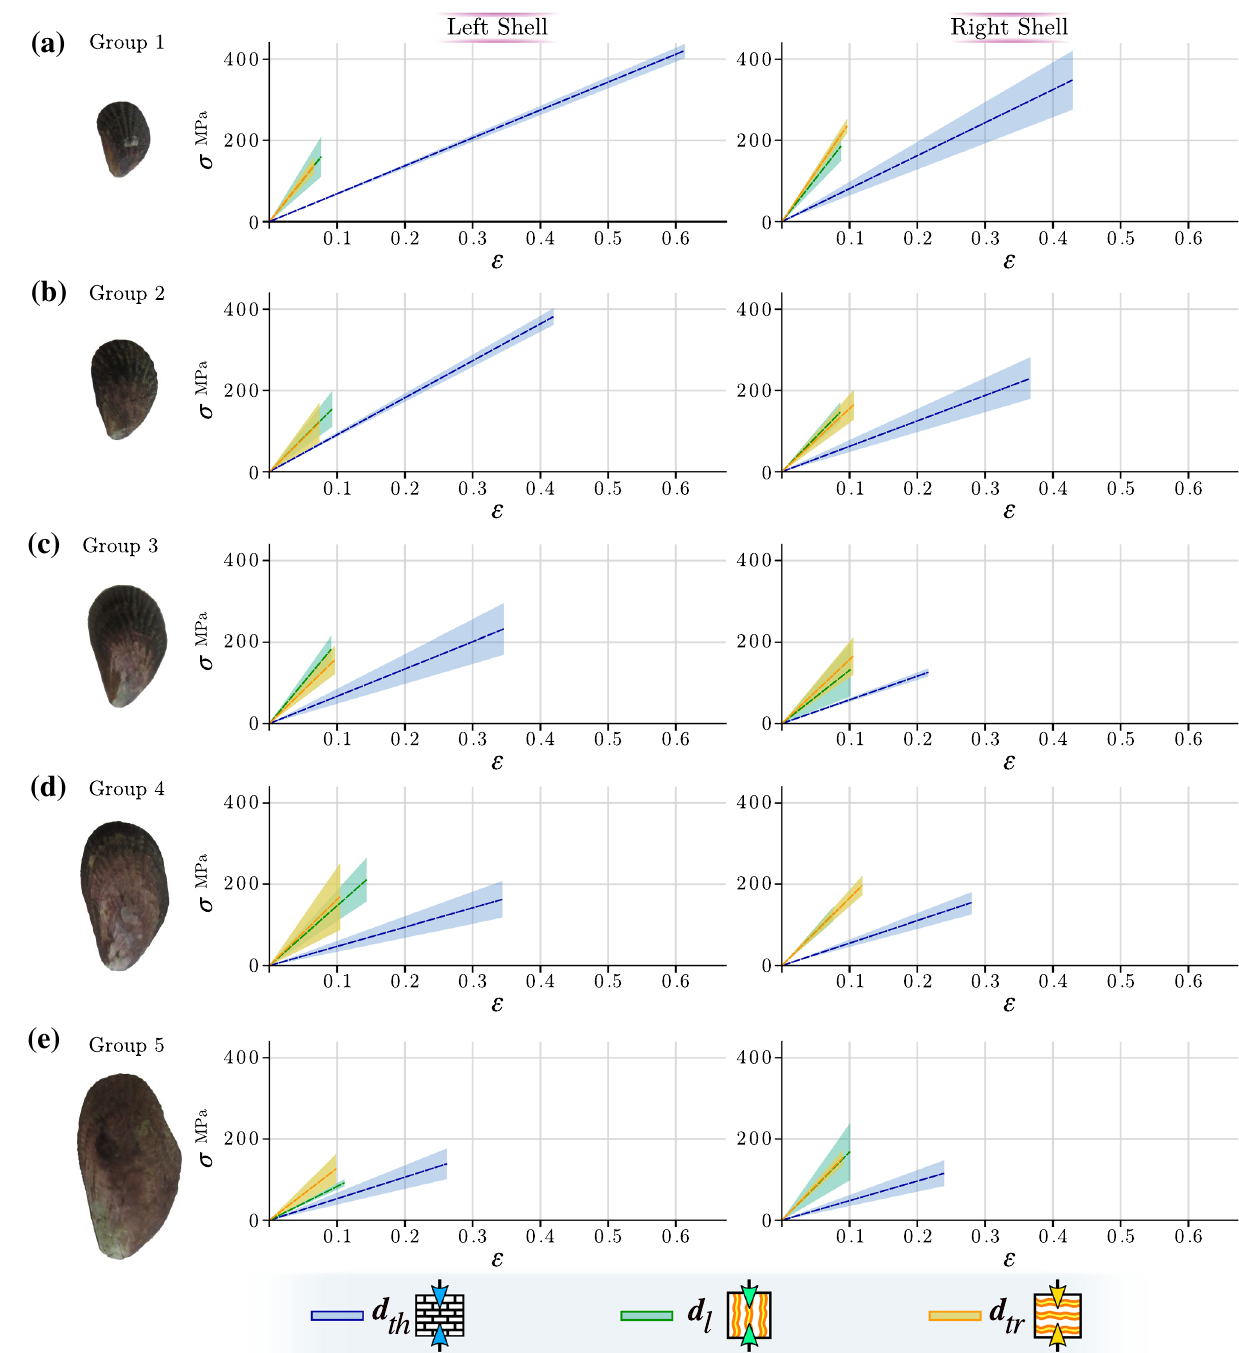
Figure 3. Standard deviation (SD) of the stress–strain curve ( σ − ε ) of the five age/size groups (along with a photograph of the right valve representative of each group) for the left and right shells in their respective orthotropic directions of the material: thickness ( ddd th ), longitudinal ( ddd l ) and transversal ( ddd tr ) direction. ( a ) group 1, ( b ) group 2, ( c ) group 3, ( d ) group 4, ( e ) group